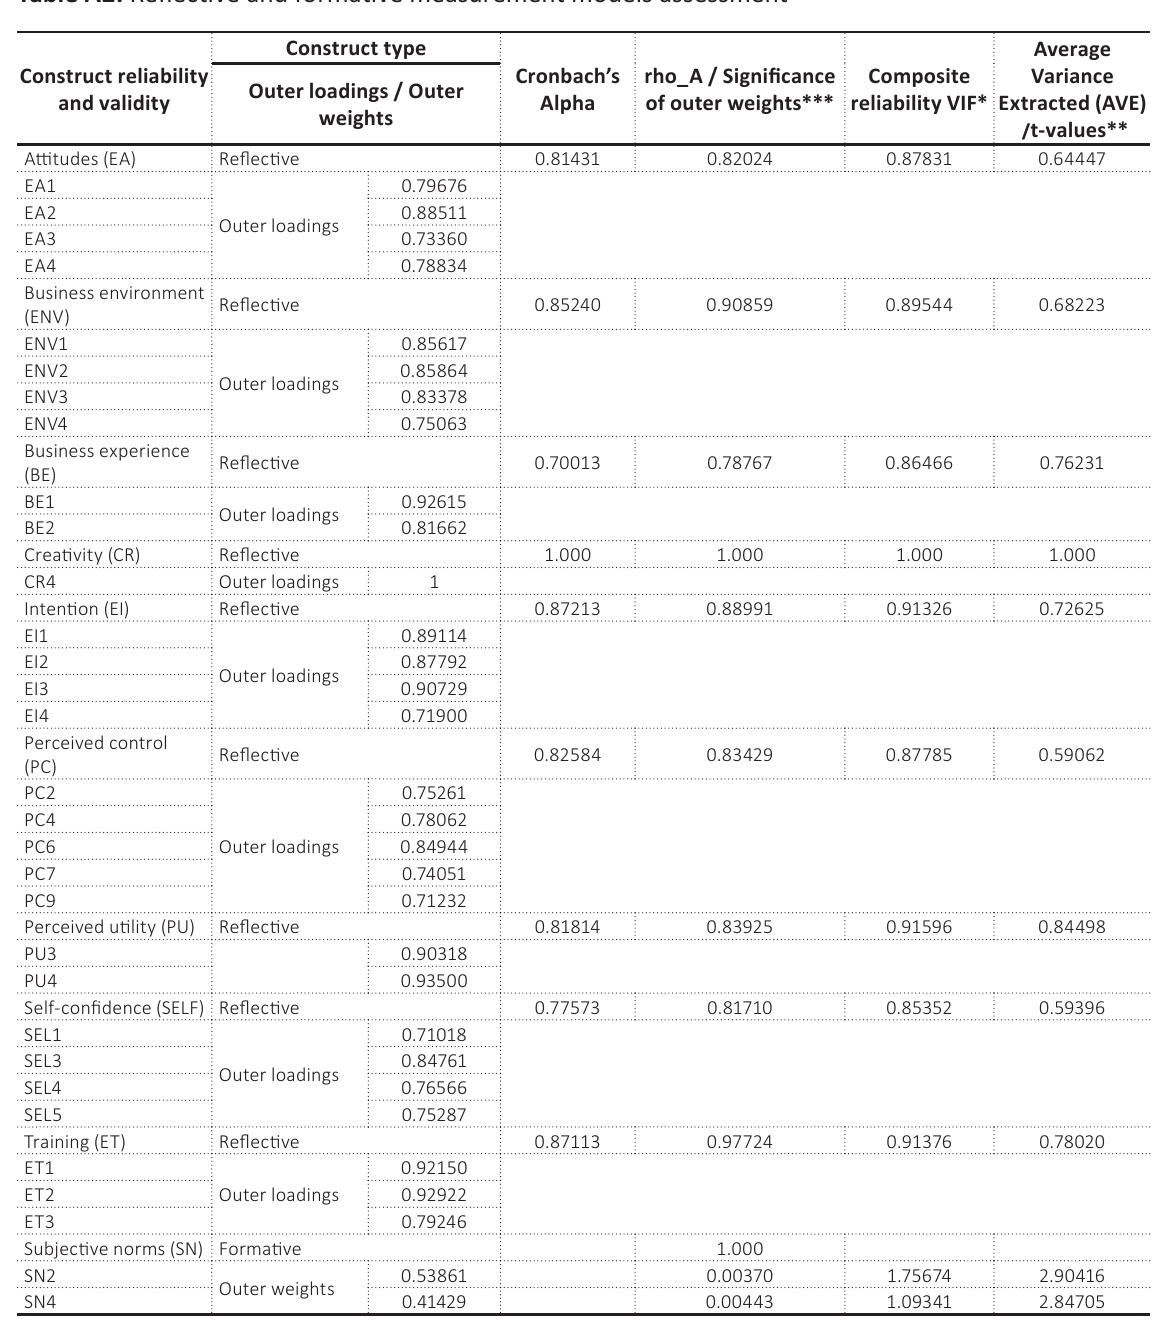
Table A2. Reflective and formative measurement models